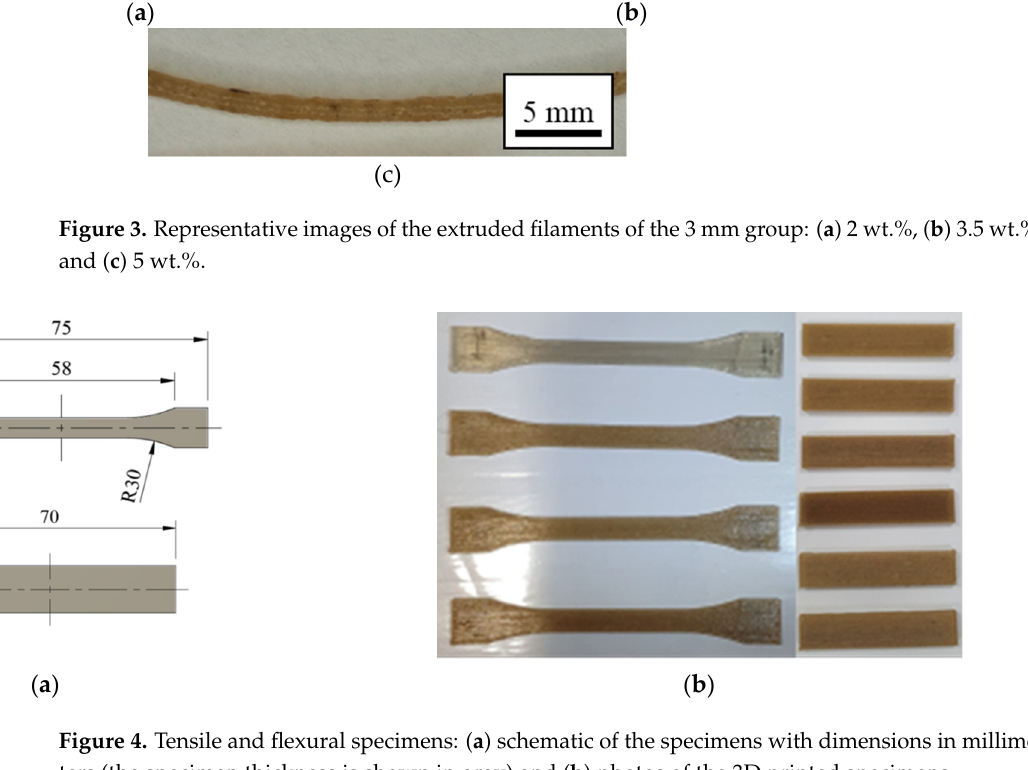
Figure 3. Representative images of the extruded filaments of the 3 mm group: ( a ) 2 wt.%, ( b ) 3.5 wt.%, and ( c ) 5 wt.%.